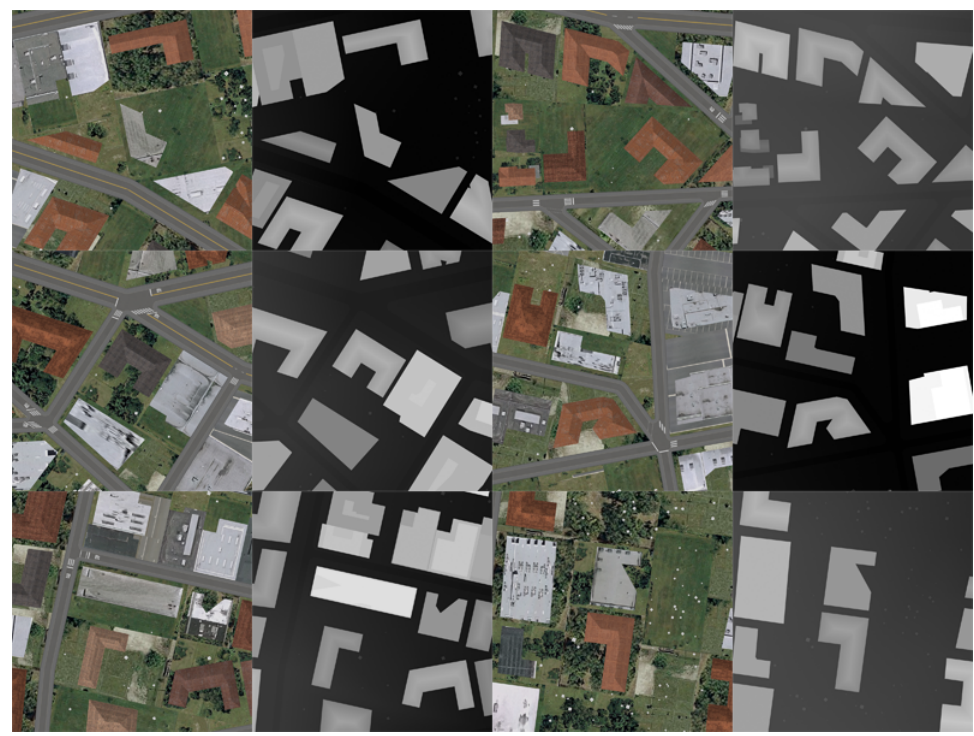
Figure 3. Synthetic dataset. The first and third columns are rendered color images and the second and fourth columns are the corresponding height maps where the intensity is proportional to their height